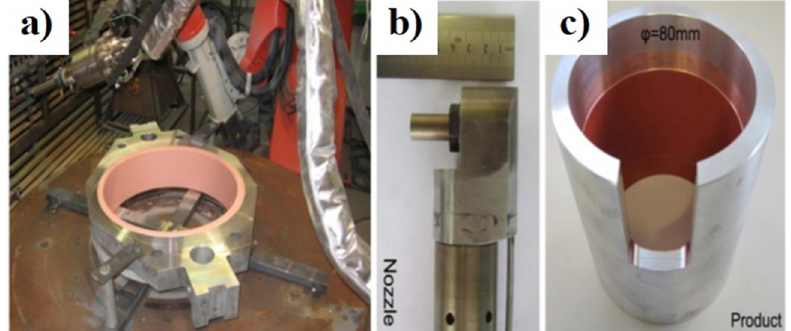
Figure 8: CSAM cylinder: ( a ) internal wall of pressure ring for food processing machine; ( b ) small - size CS nozzle; and ( c ) internal wall of small - space cylindrical pipe [ 51,52 ] .